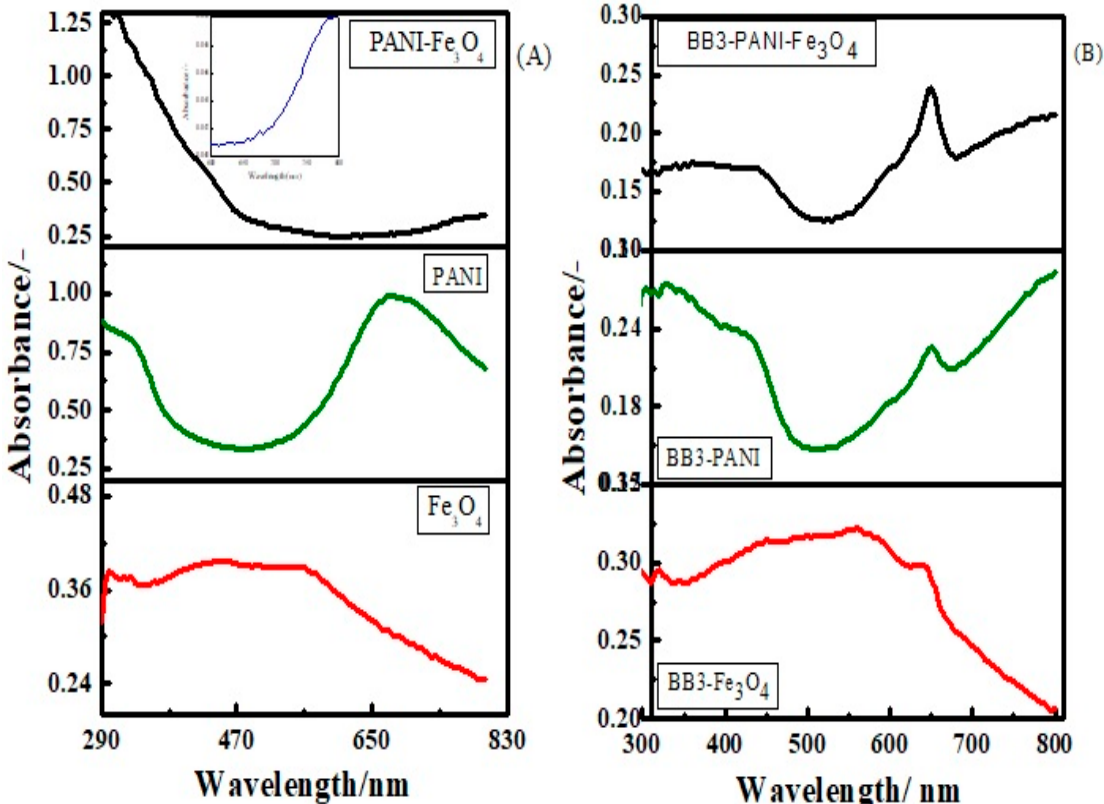
Figure 2. UV-Vis spectra of Fe 3 O 4 , PANI, and PANI / Fe 3 O 4 composites ( A ) before and ( B ) after adsorption of BB3. The inset (A) shows the spectrum of PANI / Fe 3 O 4 in the long wavelength region.